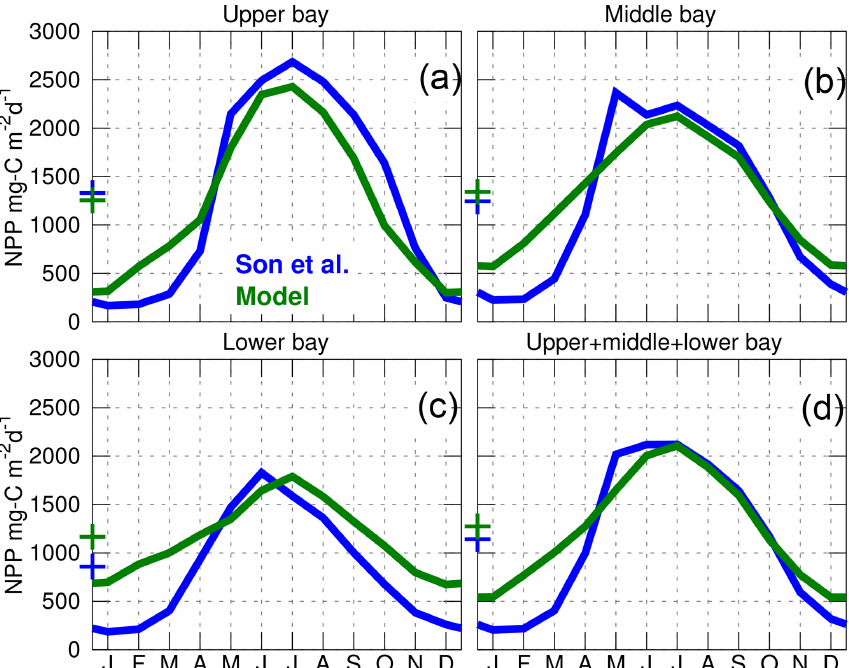
Figure 6. Seasonal climatology of the net primary production (NPP) over the period 2002–2011. The blue curves are the modeled results and the green curves are from the empirical model of Son et al. (2014) (their Fig. 7). The upper, middle and lower bay regions are defined as in Son et al. (2014) (their Fig. 1). The “+” symbols represent the annual mean value of the curves. The model results are from the control experiment (Table